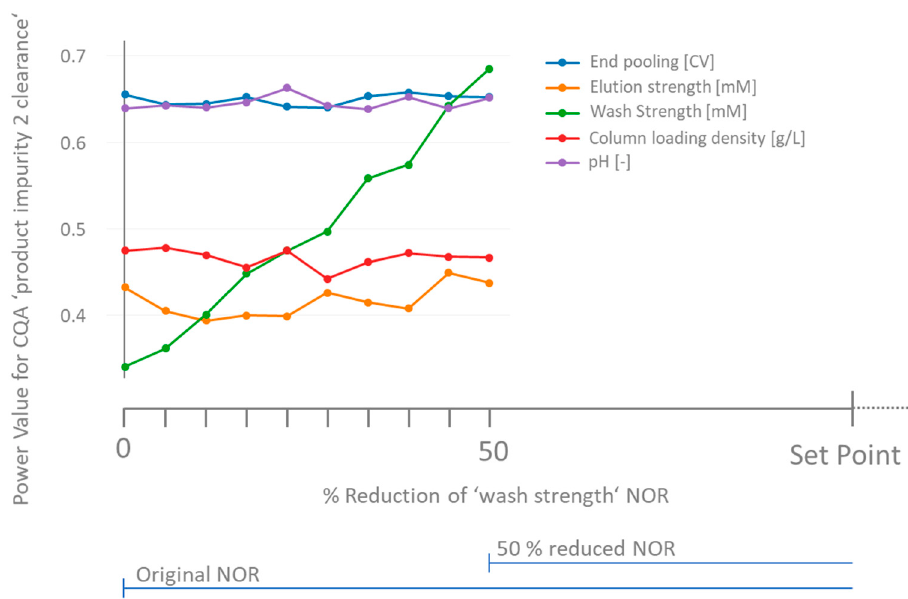
Figure 2. Retrospective power values for ‘product impurity 2 clearance’ for unit operation CC 1 as a function of tightened NOR of process parameter ‘wash strength’. At the initially defined NOR, the power value is 0.34. Upon reducing the NOR symmetrically by 50%, the power value for this process parameter increases to 0.68. The power values of the residual process parameters remain unaffected.